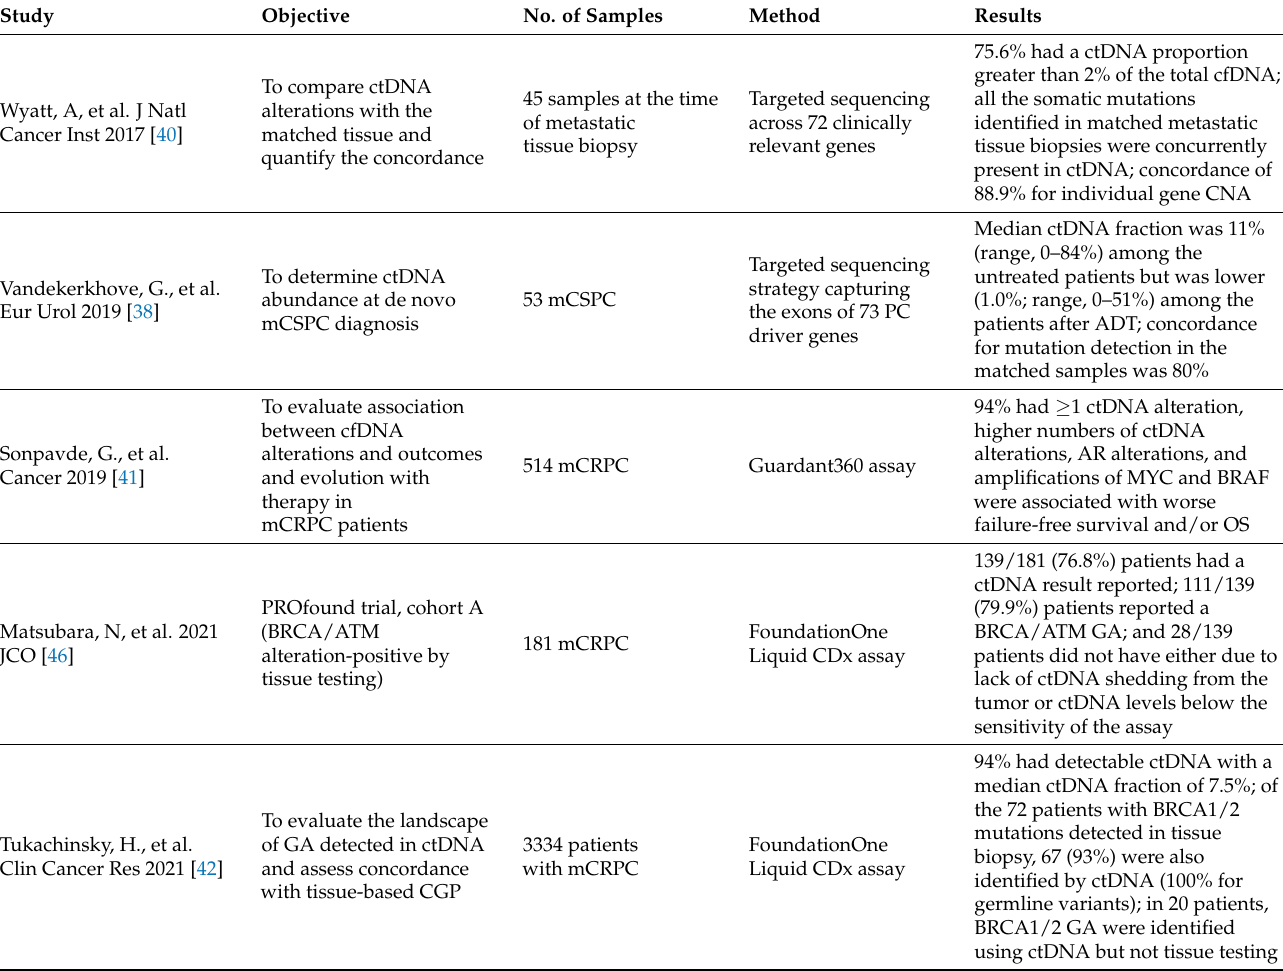
Table 2. Summary of the recently published papers that used ctDNA sequencing for the detection of HRR alterations in